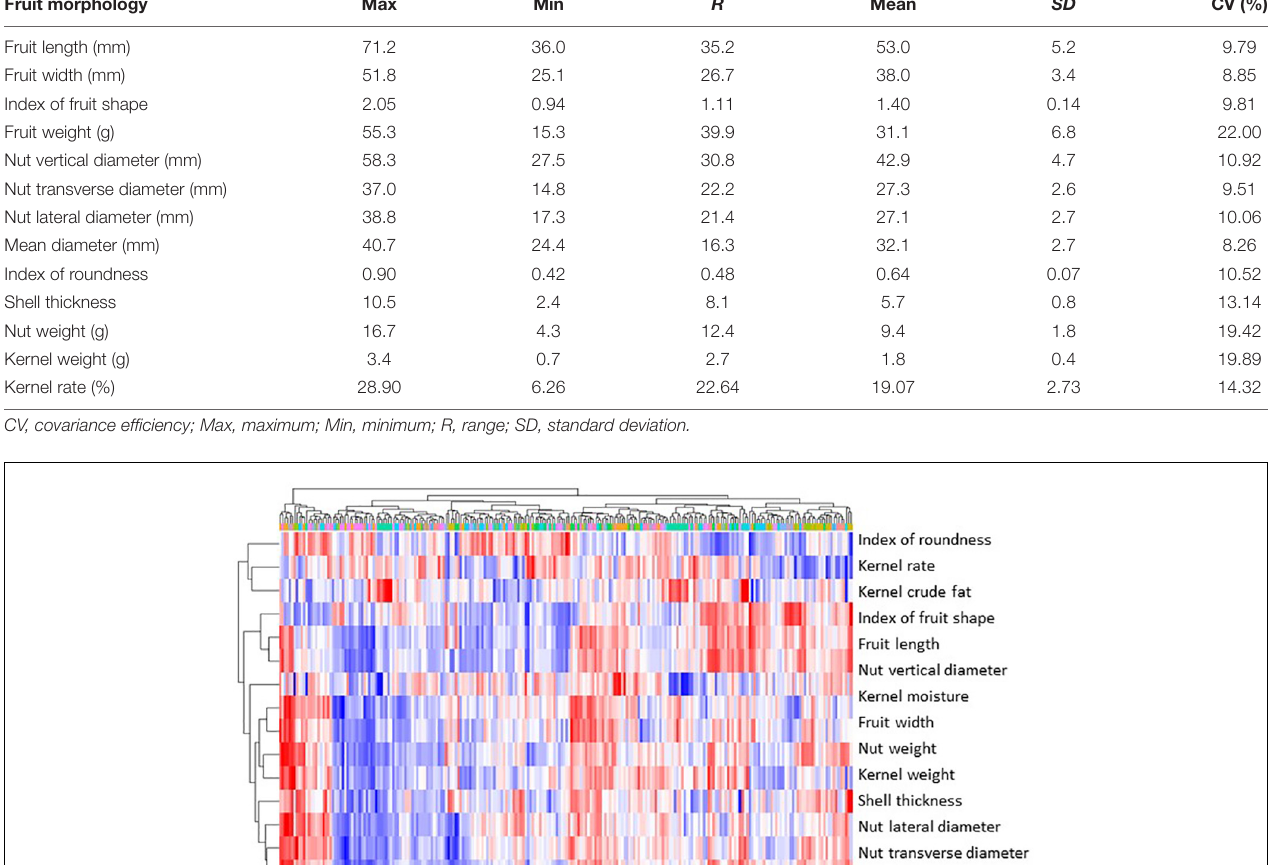
TABLE 1 | Summary of 13 fruit morphological traits of 12 J. mandshurica populations. Fruit morphology